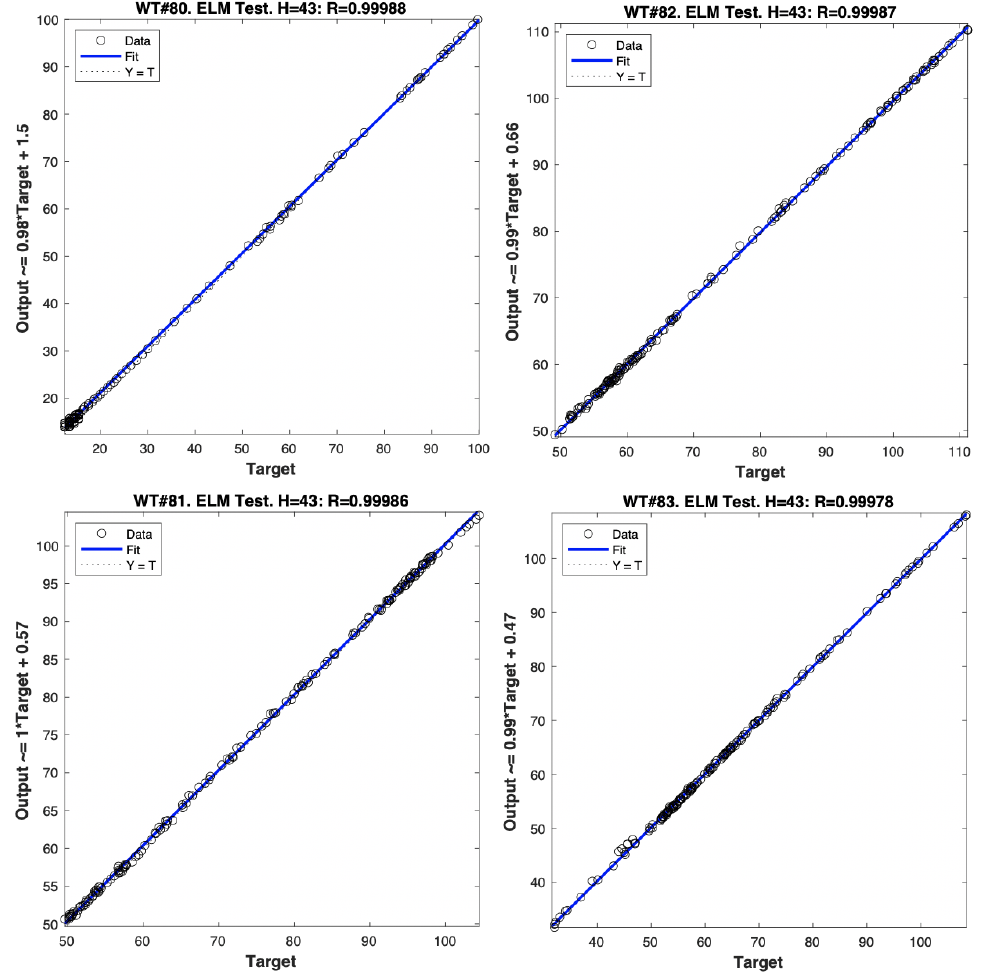
Figure 6. Regression plots of the plant model for turbines WT#80 to WT#83, using the SCADA data generated during one week for the case of H =